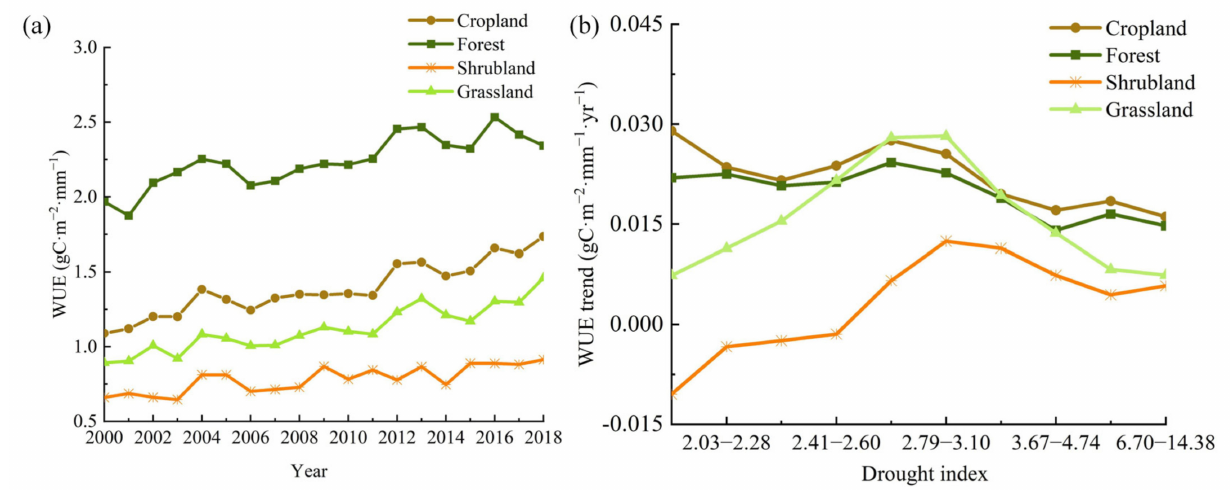
Figure 5. ( a ) Temporal variations in the annual WUE and ( b ) the trend of the WUE with drought index for the different vegetation